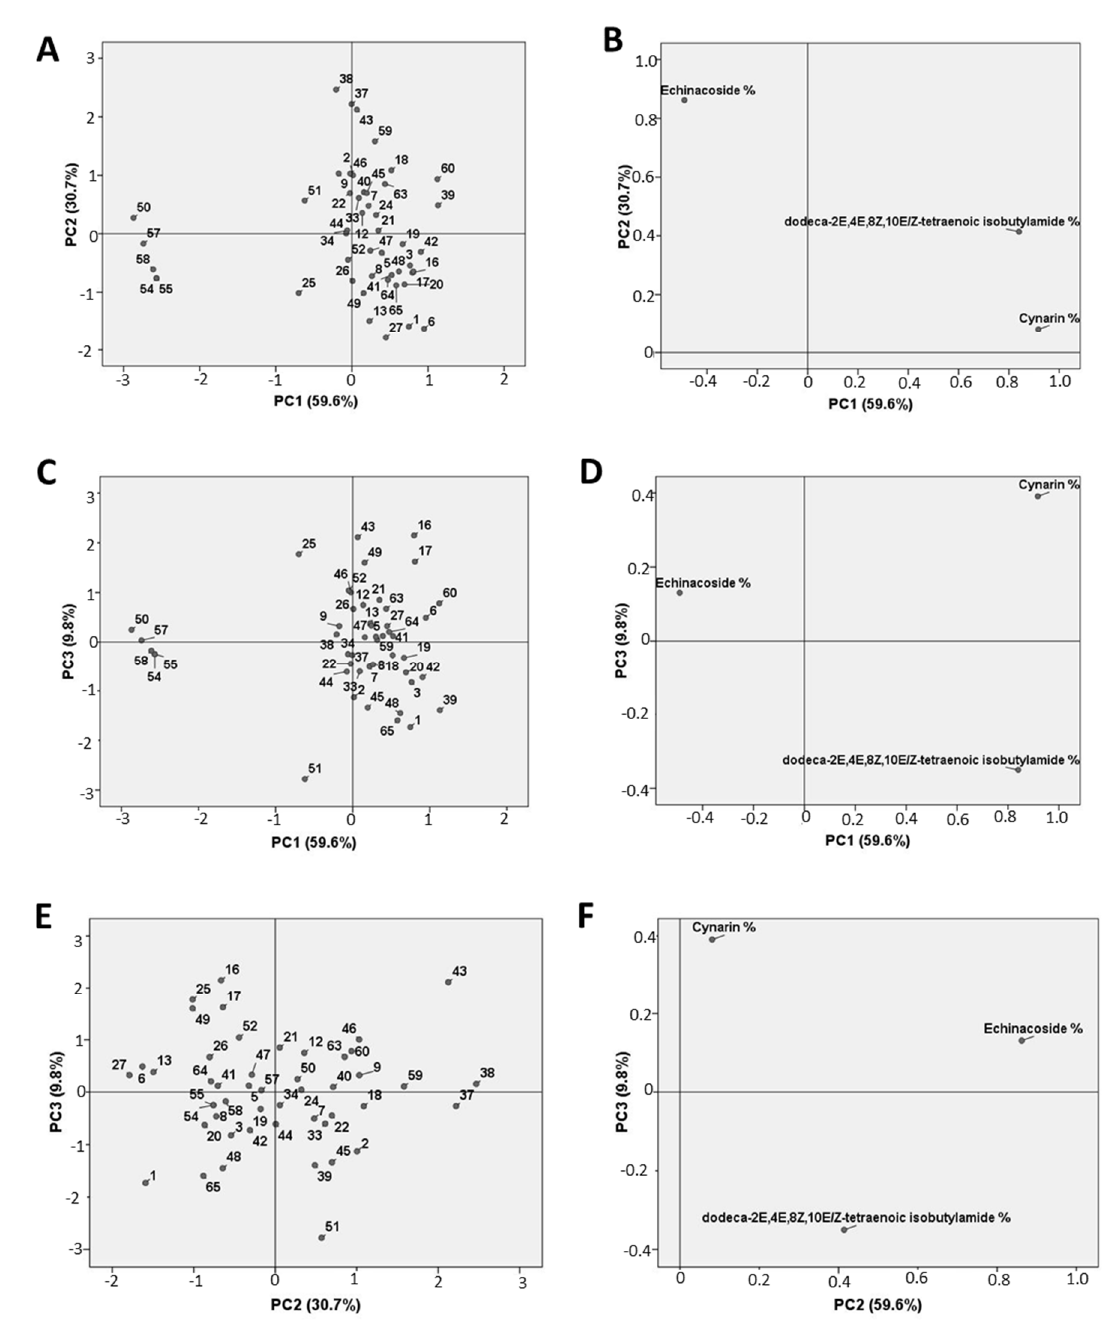
Figure 1. Principal Component Analysis (PCA) score plots and loading plots of 48 E. angustifolia accessions. Mean values of cynarin, echinacoside and dodeca-2E,4E,8Z,10E / Z-tetraenoic isobutylamide percentage content were used as variables. ( A ): score plot of PC1 vs. PC2; ( B ): loading plot of PC1 vs. PC2; ( C) : score plot of PC1 vs. PC3; ( D) : loading plot of PC1 vs. PC3; ( E) : score plot of PC2 vs. PC3; ( F) : loading plot of PC2 vs. PC3.